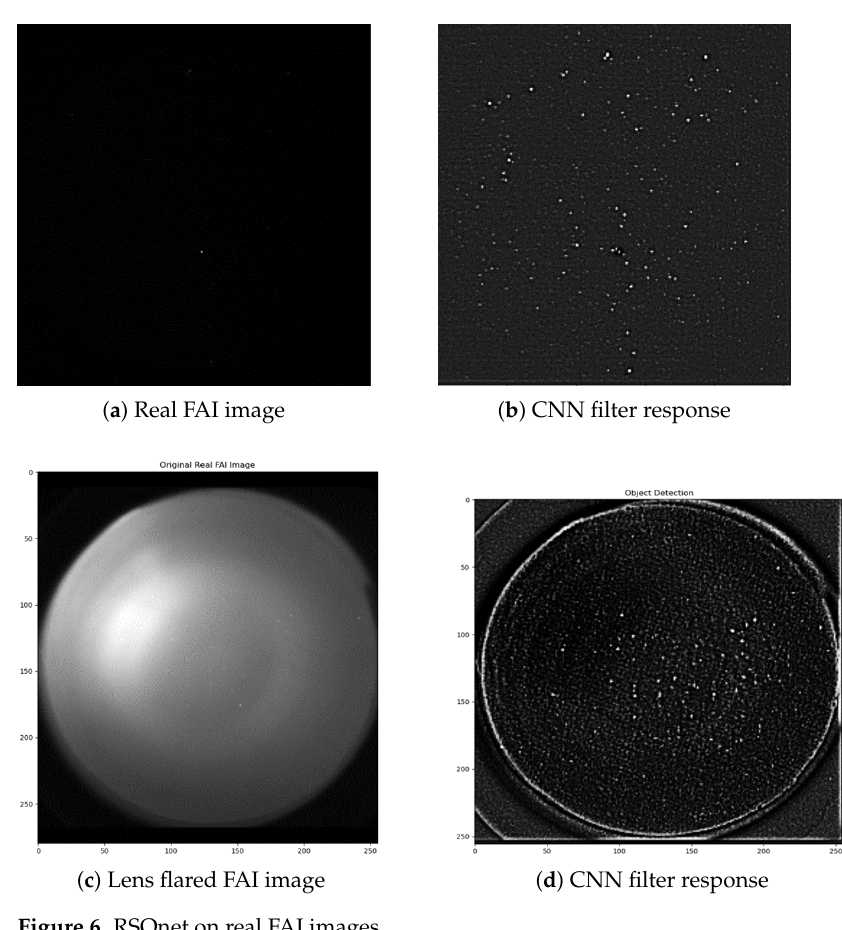
Figure 6. RSOnet on real FAI